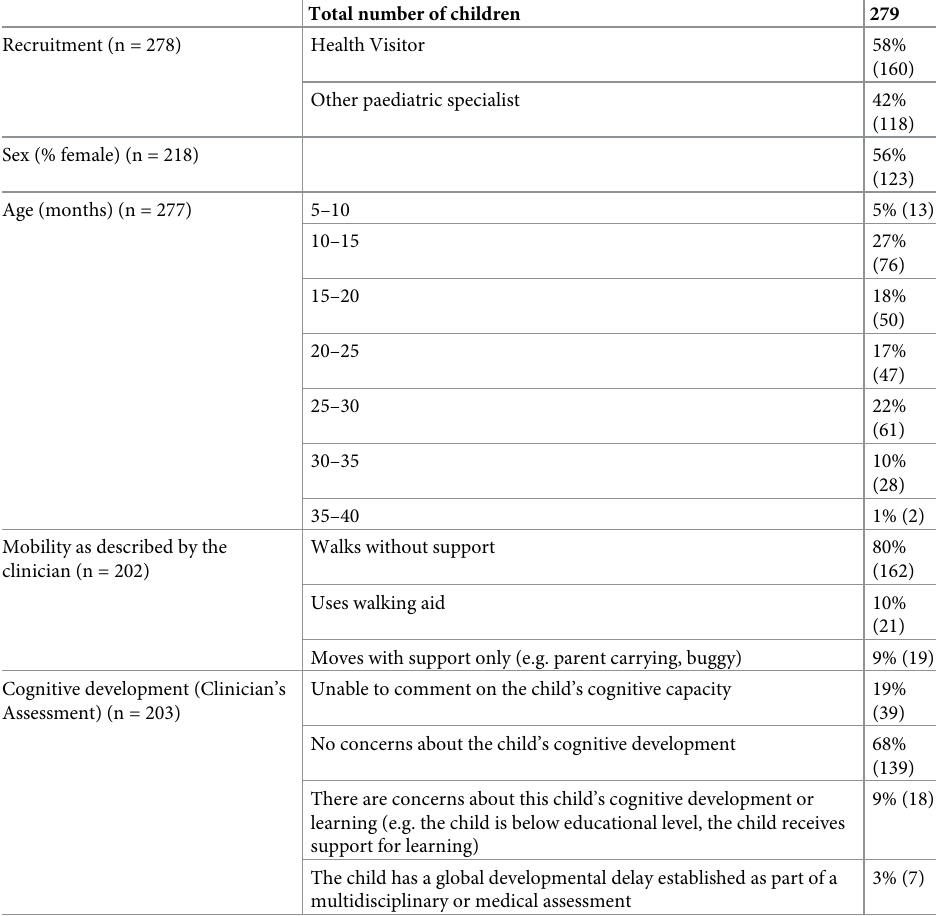
Table 1. Shows the distribution of ages and recruitment pathways of the